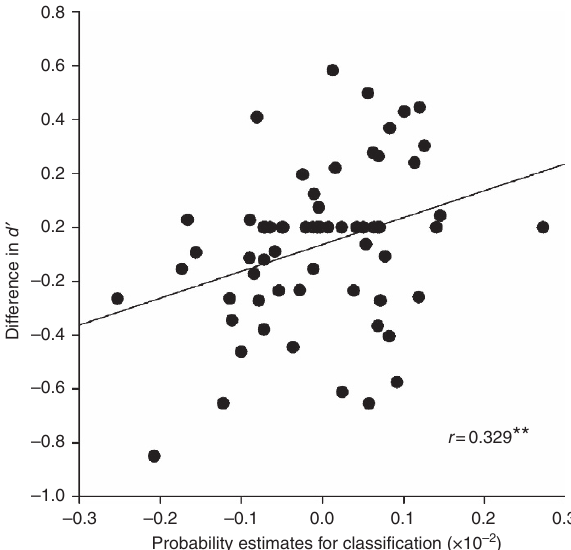
Figure 3 | Correlation between classification probability estimates and overnight memory consolidation during SWS sleep. The more confident the classifier was in placing each subject in the correct condition, the more positive the change in memory performance during later recall. Spearman’s rho is reported. ** P o 0.01.